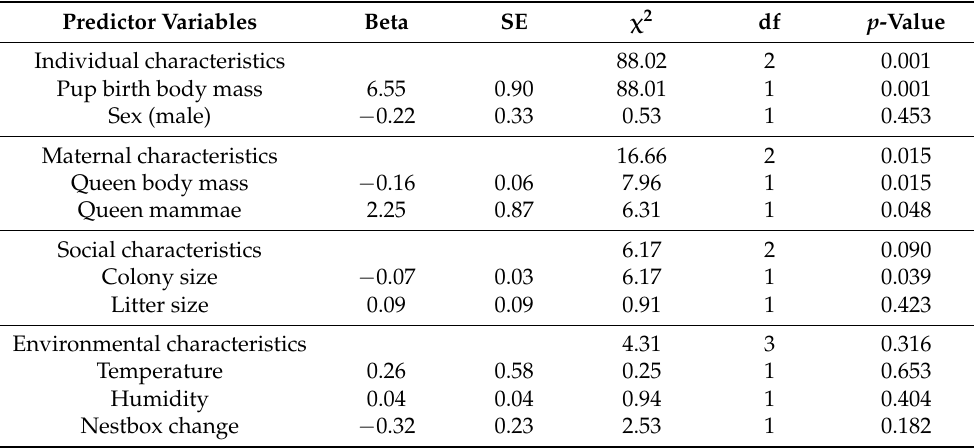
Table 2. Summary table of the likelihood ratio tests used to compare offspring survival with respect to different predictors ( n = 585 pups).